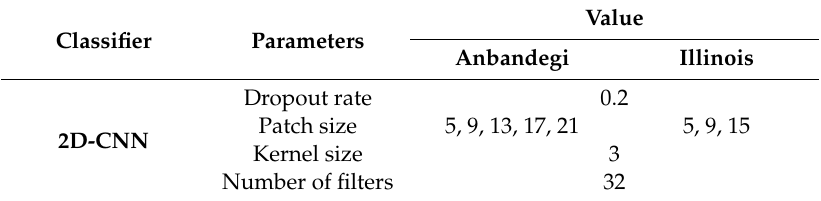
Table 4. List of hyper-parameters of 2D-CNN models applied to the two study